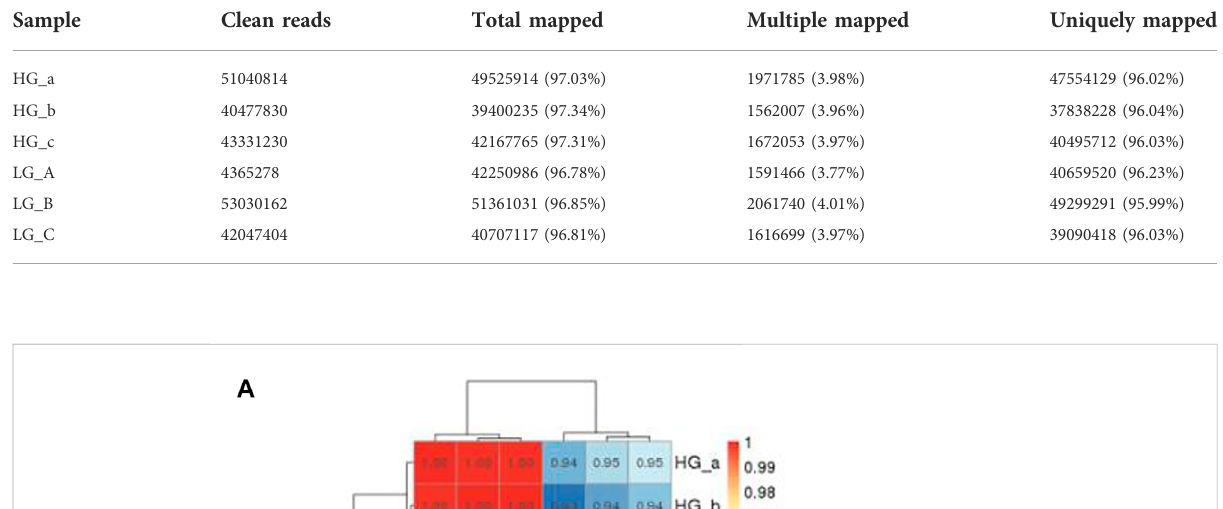
TABLE 2 RNASeq Map statistics.